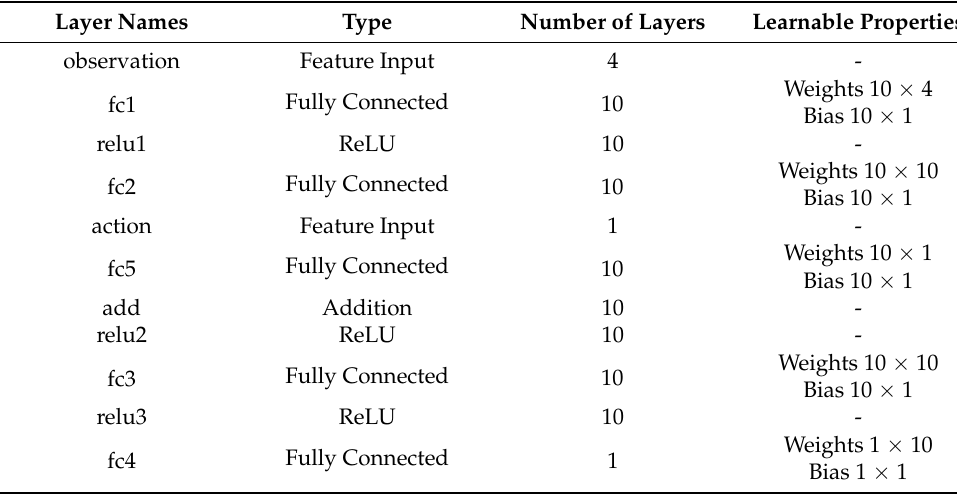
Table 3. DDPG Agent definition parameters.